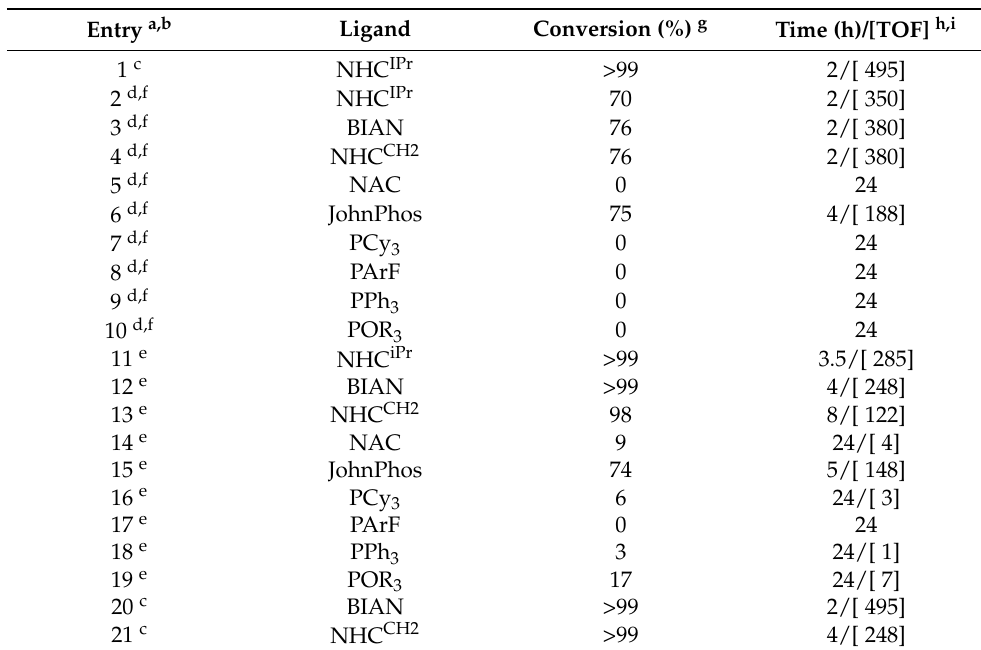
Figure 18. Structure of ligands used by Zuccaccia et al. Reprinted with permission from Ref. [60] Copyright 2016 American Chemical Society. Table 19. L–Au–X (0.1 mol%) catalyzed hydration of 3-hexyne at 30 ◦ C in the presence of NBu 4